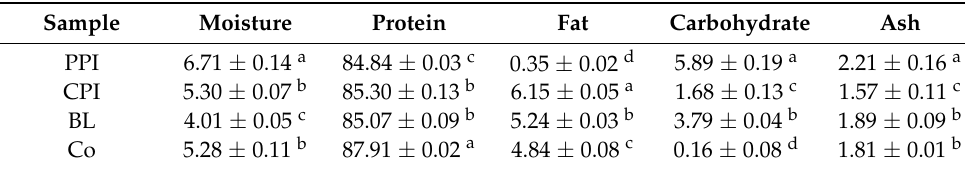
Table 3. Chemical composition of PPI, CPI, Co, and BL.